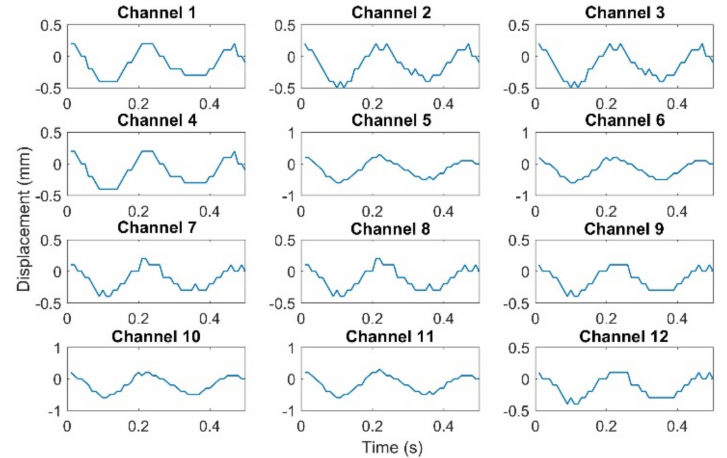
Figure 16. Input